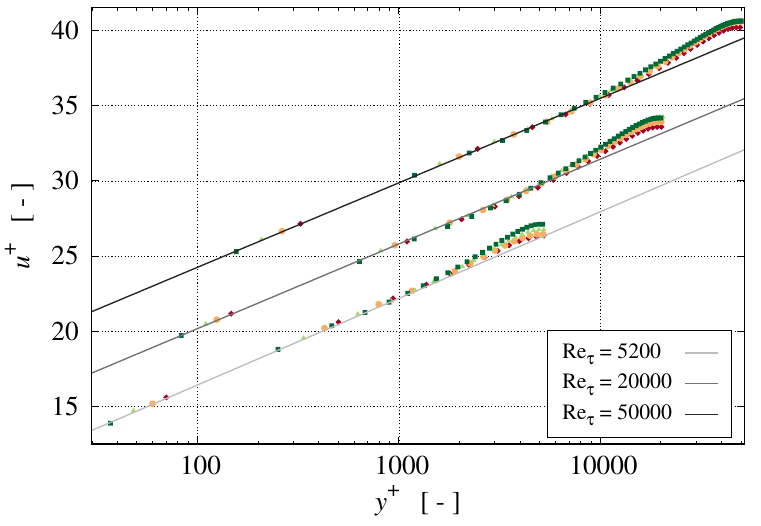
Figure 8. Non-dimensional mean velocity profiles for the three higher Reynolds numbers. With ascending Re τ the characteristic parameters of the logarithmic layer u + ( y + ) = ln ( y + ) / κ + B are: the von Kármán constant reads κ ( Re τ ) = { 0.40,0.41,0.41 } and the constants are B ( Re τ ) = { 4.9,4.9, 5.0 } . The color codes of the symbols are given in Table 1. To improve the comparison, profiles for Re τ = 20,000 [50,000] are vertically shifted by ∆ u + = 4 [ 8 ]